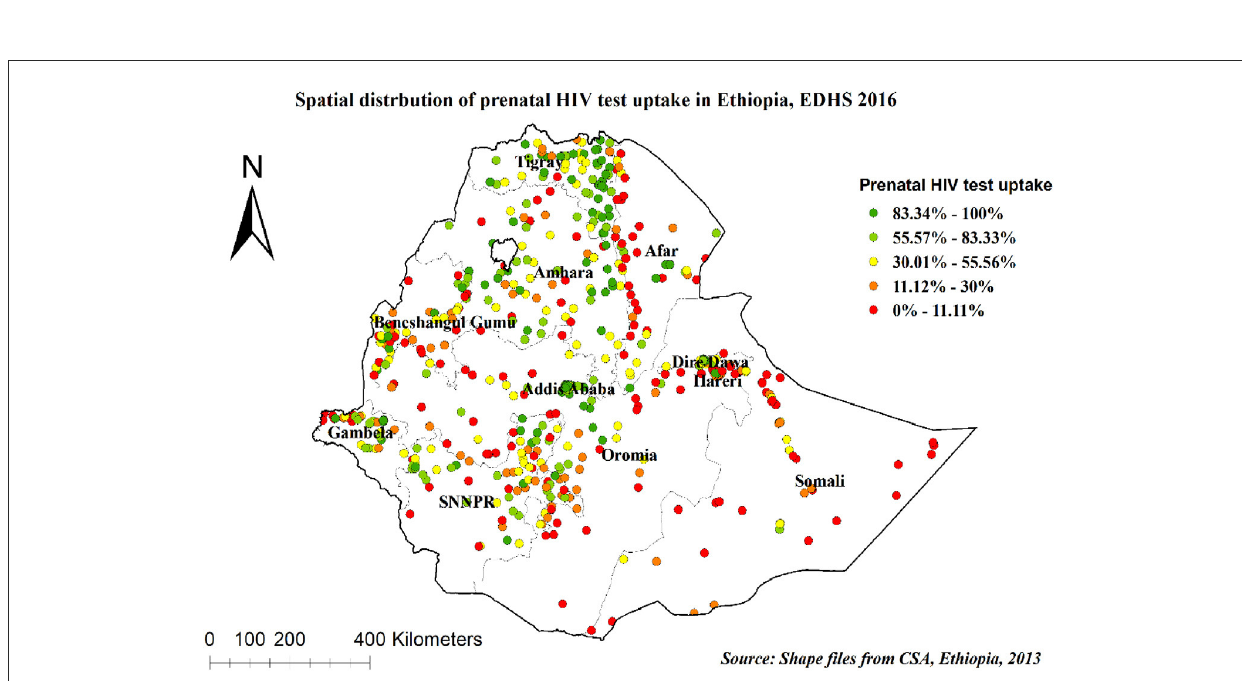
FIGURE2 Spatial distribution of prenatal HIV test uptake in Ethiopia, 2016.